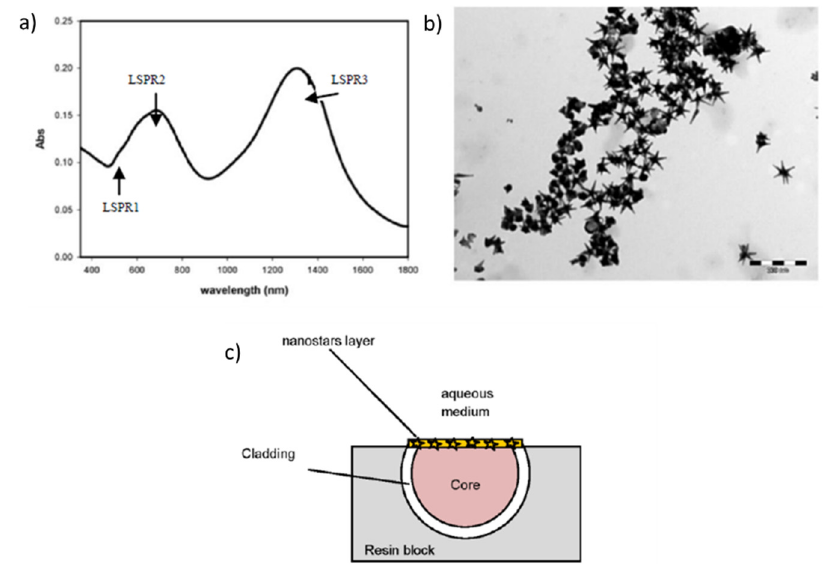
Figure 3. ( a ) UV-Vis-NIR absorption spectrum of the synthesized gold nanostars (GNS) with the three characteristic Localized Surface Plasmon Resonance (LSPR) absorption bands; ( b ) TEM image of the five-branched GNS; ( c ) Aspect in detail of the LSPR optical fiber. Reprinted with permission of [7].